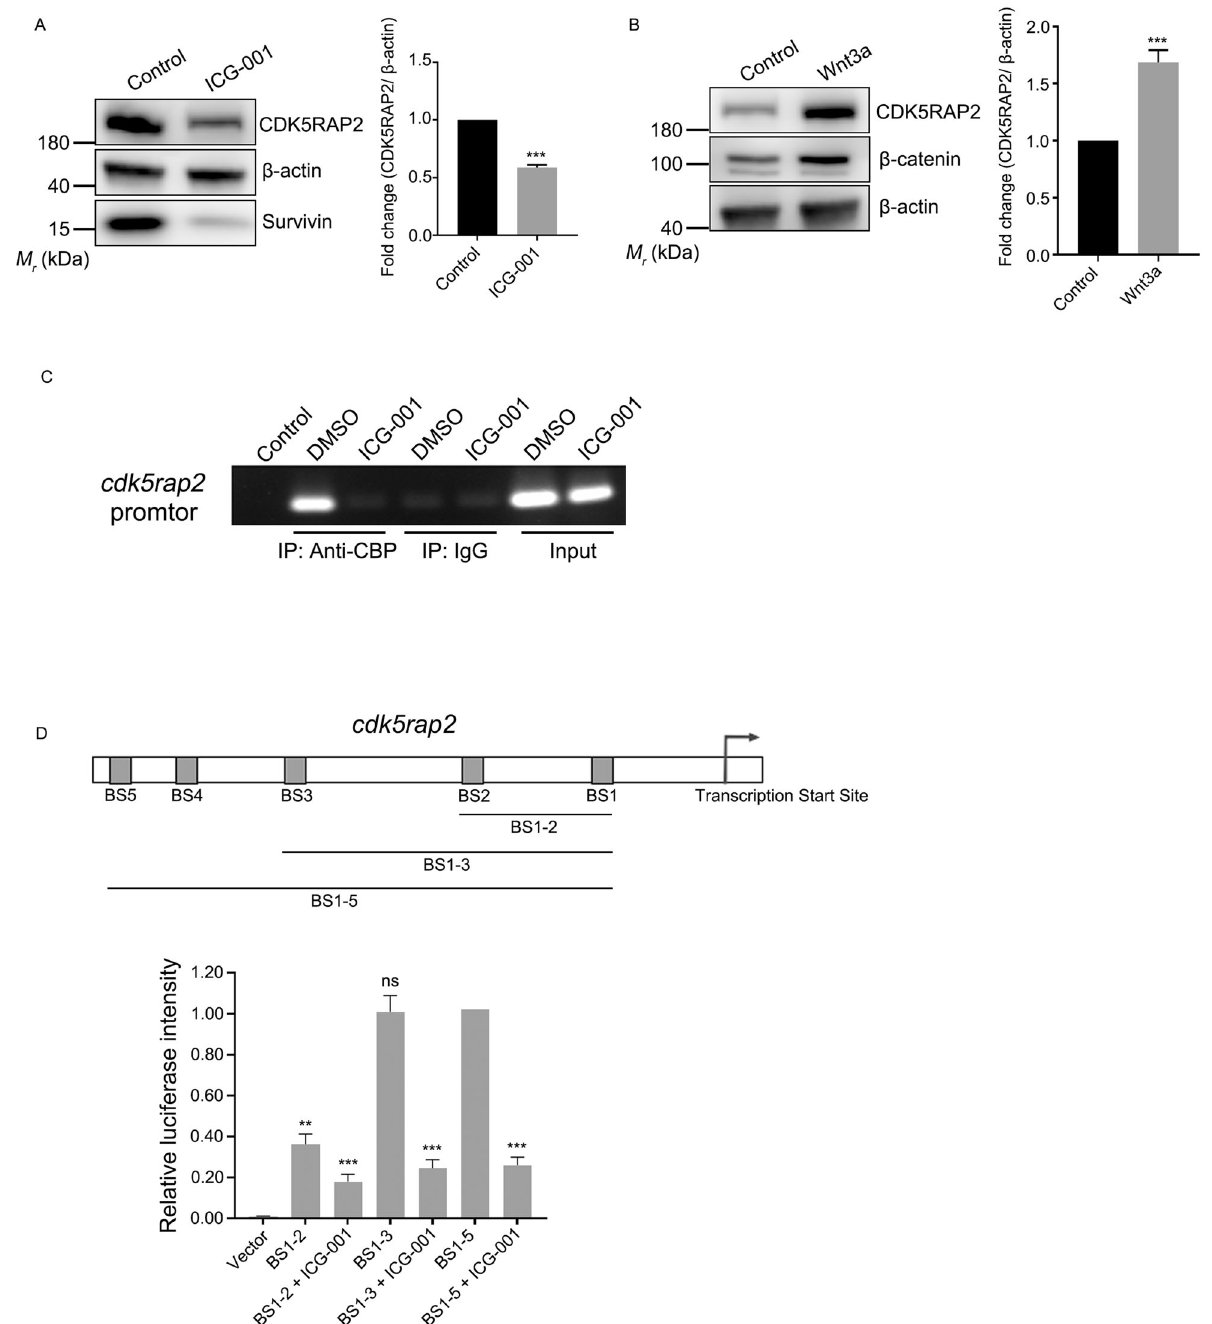
Fig. 2 CDK5RAP2 expression is regulated by the Wnt signaling pathway. A , B HOK cells were treated with 25 μ M ICG-001 A or 100 ng/mL Wnt3a B for 24 h and then cell lysates were immunoblotted with the indicated antibodies. CDK5RAP2 protein levels were quanti fi ed and normalized to the β -actin protein levels. C ChIP assay was performed using rabbit anti-CBP antibody or normal rabbit IgG. RPE1 cells were treated with DMSO as mock treatment or 25 μ M ICG-001. D Schematic of predicted CBP-binding sites in the cdk5rap2 promoter region. Binding between CBP and the cdk5rap2 promoter was determined using a dual-luciferase reporter assay. RPE1 cells transfected with distinct promotor fragments were treated with or without ICG-001. Fire fl y luciferase intensity was normalized relative to Renilla luciferase intensity. Data are presented as means ± SD; ns no signi fi cance, ** P < 0.01, *** P < 0.001, two-tailed Student ’ s t depletion of CDK5RAP2 resulted in reduced cell migration in both by CDK5RAP2-knockdown cells was considerably decreased com- the wound-healing assay (Fig. 4A, B) and the lower chamber of the pared to that in the control group (Fig. 3C). These results reveal that transwell assay (Fig. 4C). Collectively, these fi ndings indicate that the knockdown of CDK5RAP2 interferes with tumorigenesis. knocking down CDK5RAP2 impedes the migration of OSCC cells We utilized the wound-healing and transwell assays to evaluate and tumorigenesis in vivo. the impact of CDK5RAP2 knockdown on cell migration. Notably,